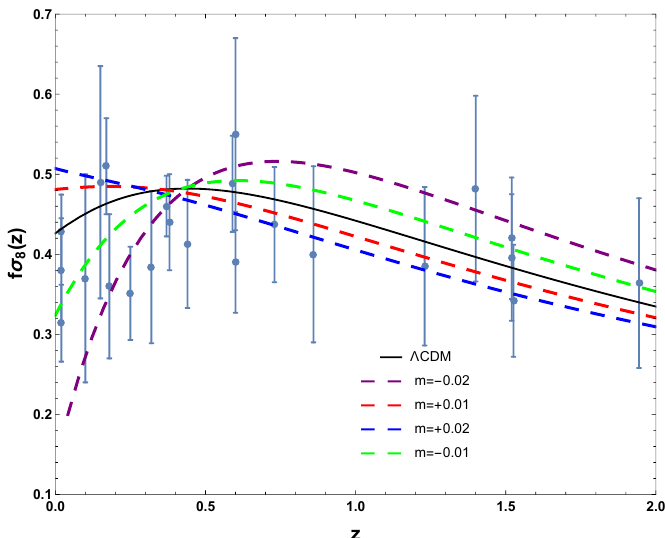
Figure 5. Dependence of f σ 8 ( z ) on z for different values of the parameter m with α = β = µ = ν = c 2 ε = 0.